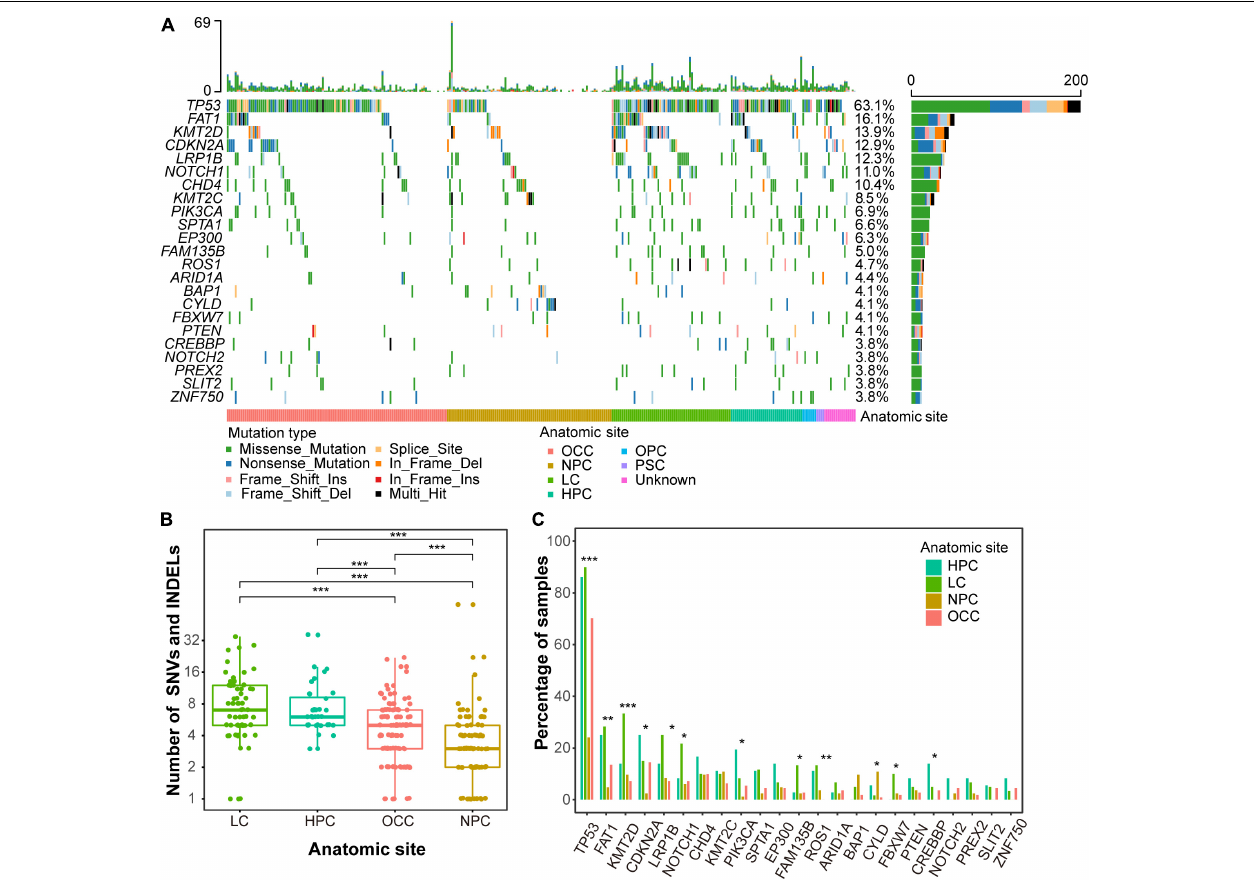
FIGURE 1 | Mutation landscape of Chinese HNSCCs across different anatomic sites. (A) Waterfall plot of top 23 frequently mutated genes. Each row indicates a gene, and each column represents a patient. Patients are sorted by anatomic site. Bars on left show number of samples mutated for genes, whereas bars on top represent number of mutation for samples. Different mutation types are represented by different colors. (B) Mutation load by anatomic sites. X-axis indicates anatomic sites, and y-axis indicates number of mutations, including SNVs and INDELs. Each point represents one patient. (C) Mutation frequency of recurrent genes by anatomic sites. Anatomic sites are shown in different colors. * p < 0.05, ** p < 0.01, *** p <